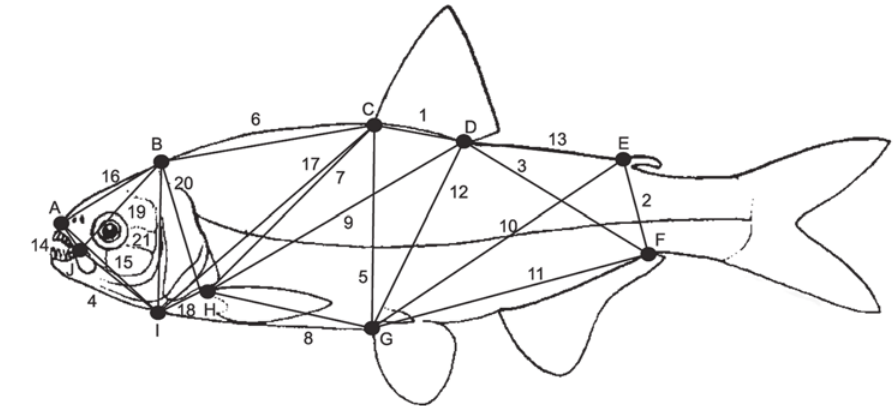
Fig. 1. Landmarks (letters) determined for delimiting trusses, and measurements (numbers) between them (adapted from Fowler, 1948). Descriptions of measurements are provided in Table 1. Table 1. Variable loadings for the principal component analysis of the three morphotypes of Astyanax gymnodontus . Truss measurements (numbers) are indicated with landmarks (letters) shown according to Fig. 1. The following abbreviations were used: maxil. comm.: maxillary commissure; supraoc. process: supraoccipital process. The modular higher eigenvectors of principal component 2 are shown in bold (see text for details).